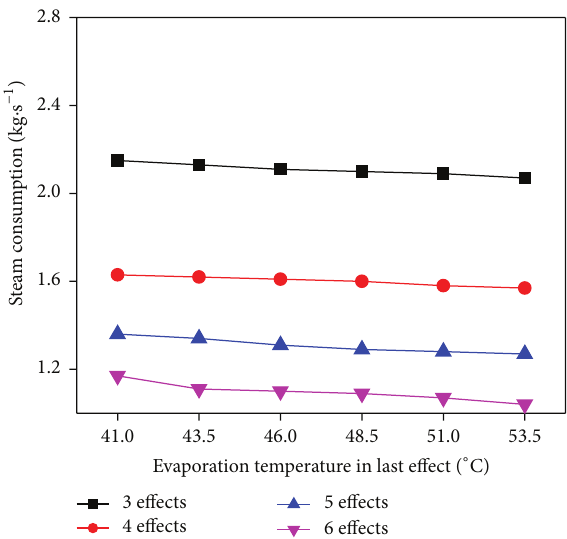
Figure 4: Variation of total heat transfer areas with evaporation temperature in last